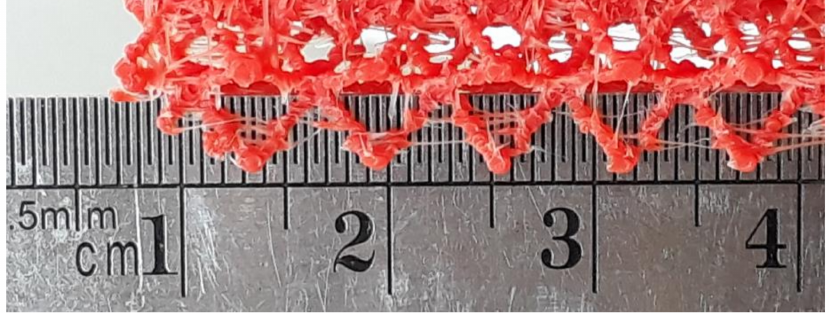
Figure 10. Multiple adjacent struts (lattice structure 1, ABS, Ender 3 scale 1.25:1). Nominal strut thickness 0.9